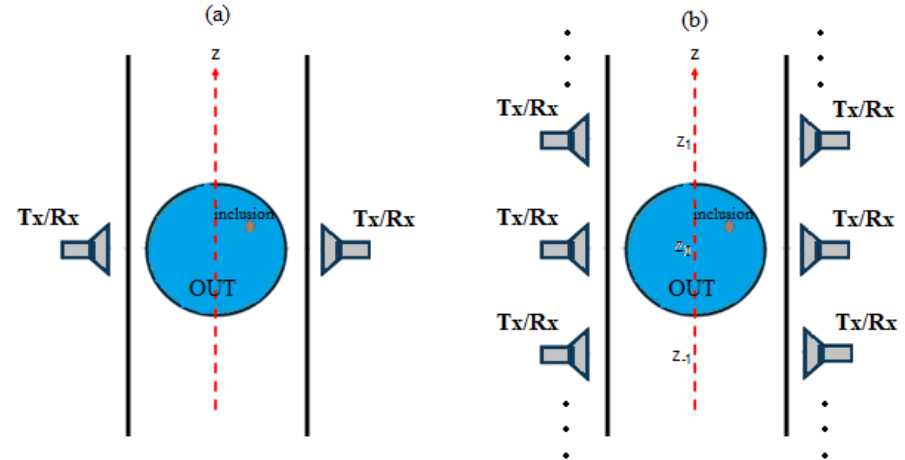
Figure 1. Basic scheme of the MWI system: ( a ) OUT (blue circle) moving along the conveyor belt with the two antennas at the two sides of the line; ( b ) equivalent configuration consisting of N couples of antennas, each working in bistatic mode and placed at the N measurement positions, z n , while the OUT stands in the middle, at the position z 0 = 0 cm.